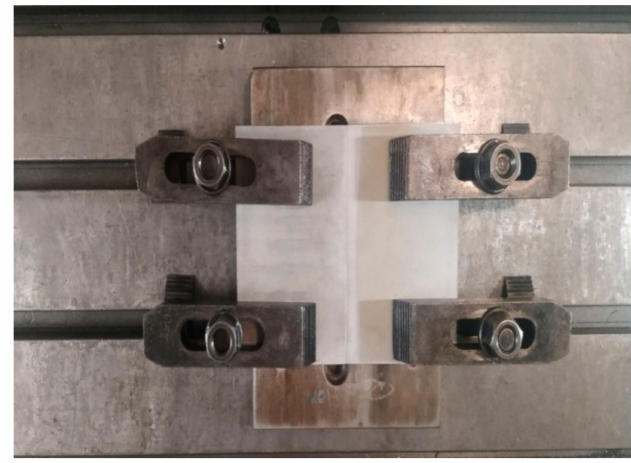
Figure 1. Machine set up for welding.